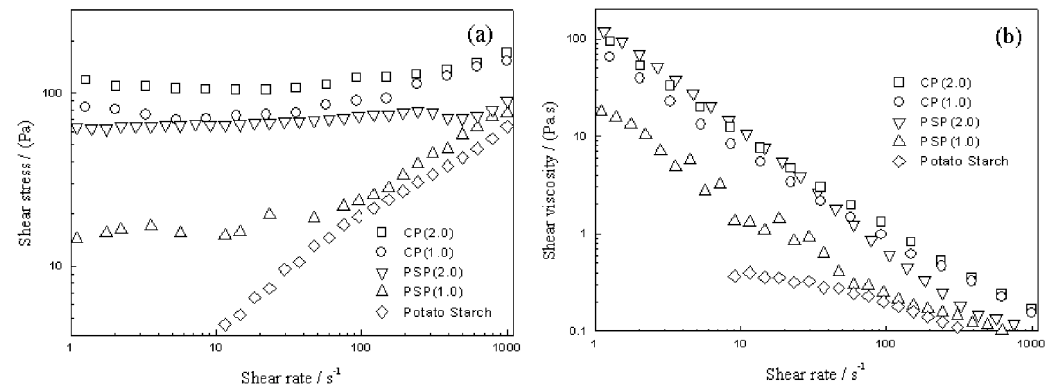
Figure 12. ( a ) Shear stress and shear rate of PSP (1.0 M), PSP (2.0 M), CP (1.0 M), and CP (2.0 M), and potato starch; and ( b ) shear viscosity and shear rate of PSP(1.0 M), PSP (2.0 M), and potato starch [43].